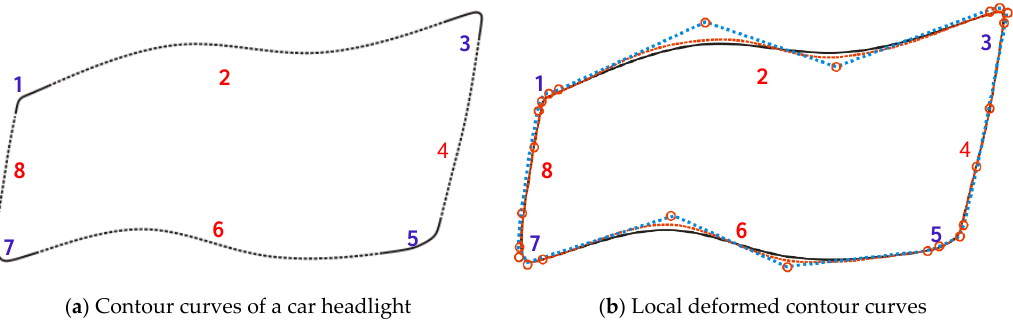
Figure 11. Eight generalized H-Bézier curves used to define the contour curves of a car headlight.